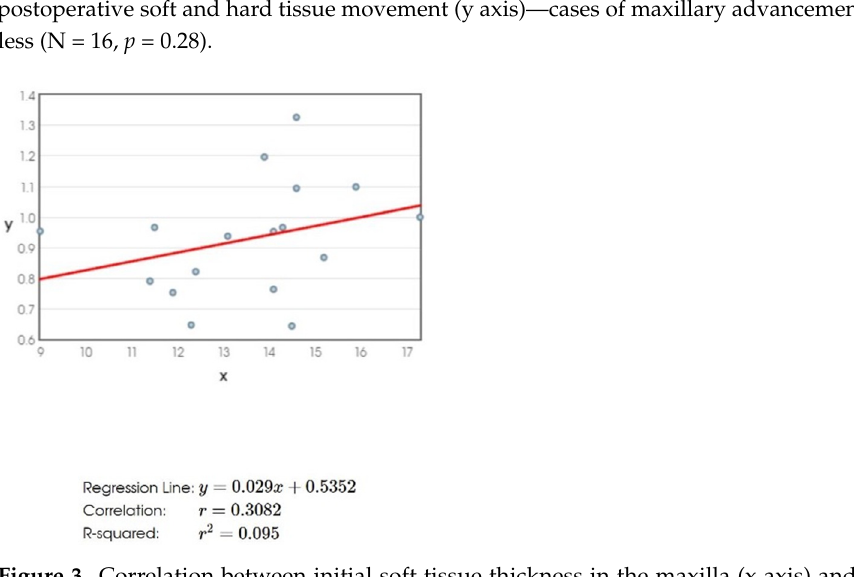
Figure 3. Correlation between initial soft tissue thickness in the maxilla (x axis) and the relation between postoperative soft and hard tissue movement (y axis)—maxillary advancement of more than 5 mm (N = 17, p = 0.23).